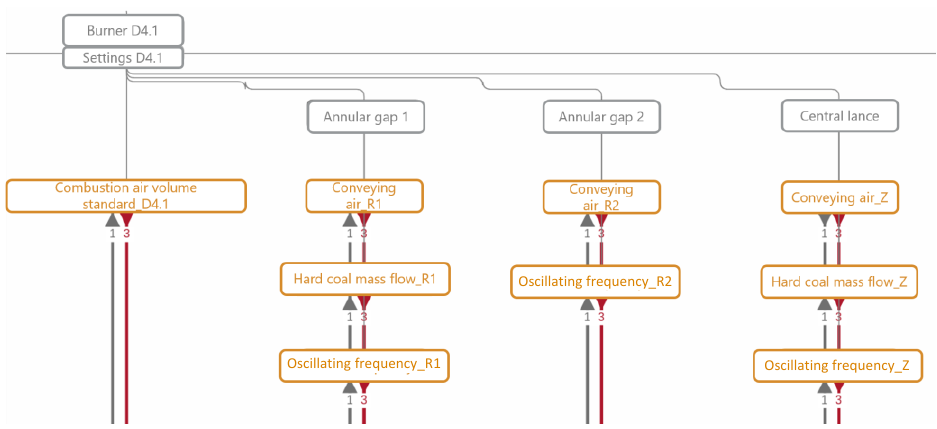
Figure 5. A selection of the cause-and-effect chains.